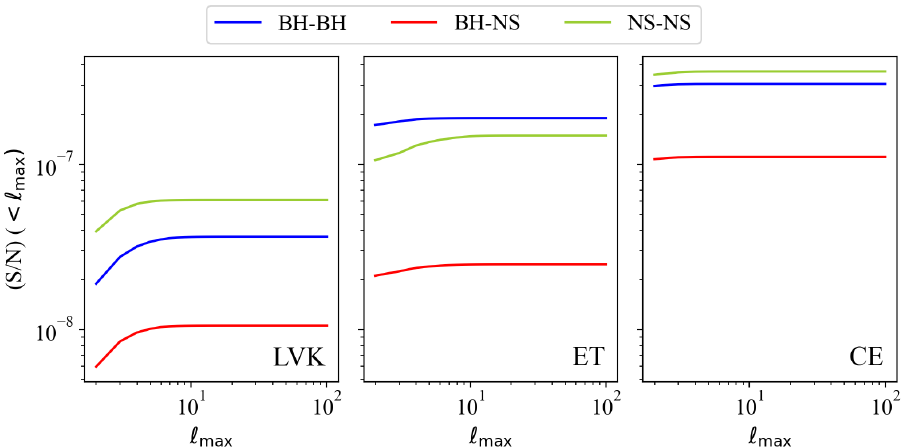
Figure 3. Cumulative S/N as a function of (cid:96) max for the SGWB auto-correlation angular power spectrum. The curves have been evaluated summing the Equation (3) from (cid:96) min = 1 up to (cid:96) max